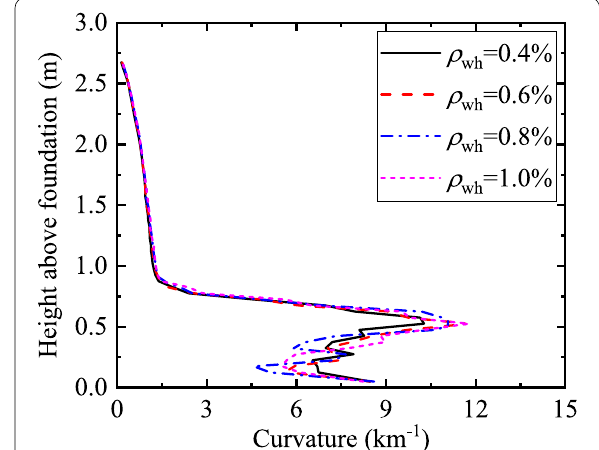
Fig. 19 Curvature distribution of specimens with different horizontally distributed reinforcement ( θ